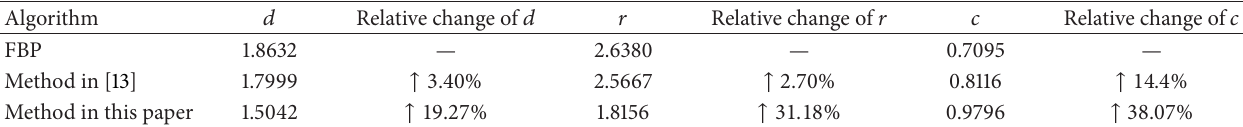
Table 2: Criteria values for the local reconstruction of the Shepp-Logan head